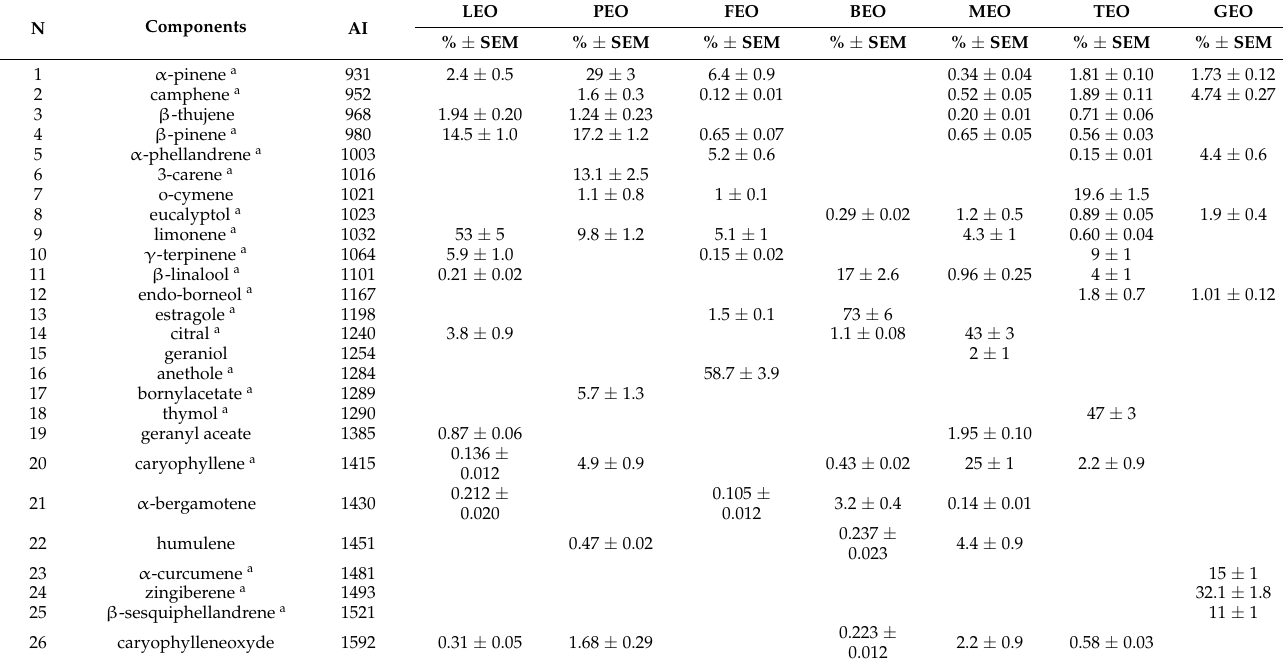
Table 1. Main components of tested